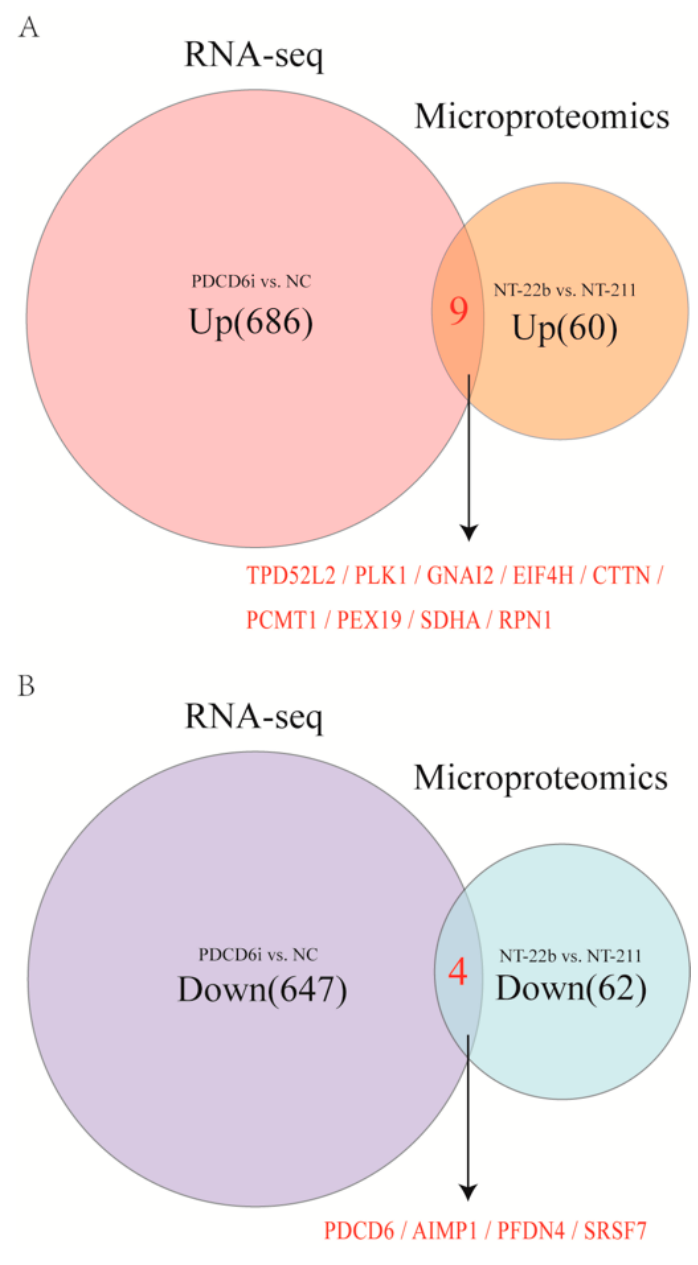
Figure 7. Discovery of potential factors regulating cloned porcine embryo development by inter- section analysis of the microproteome and transcriptome (RNA-sequencing) results. ( A ) Intersec- tion analysis of the upregulated genes and upregulated proteins in the PDCD6i and NC groups and the NT-22b and NT-211 groups, respectively. ( B ) Intersection analysis of the downregulated genes and downregulated proteins in the PDCD6i and NC groups and the NT-22b and NT-211 groups,